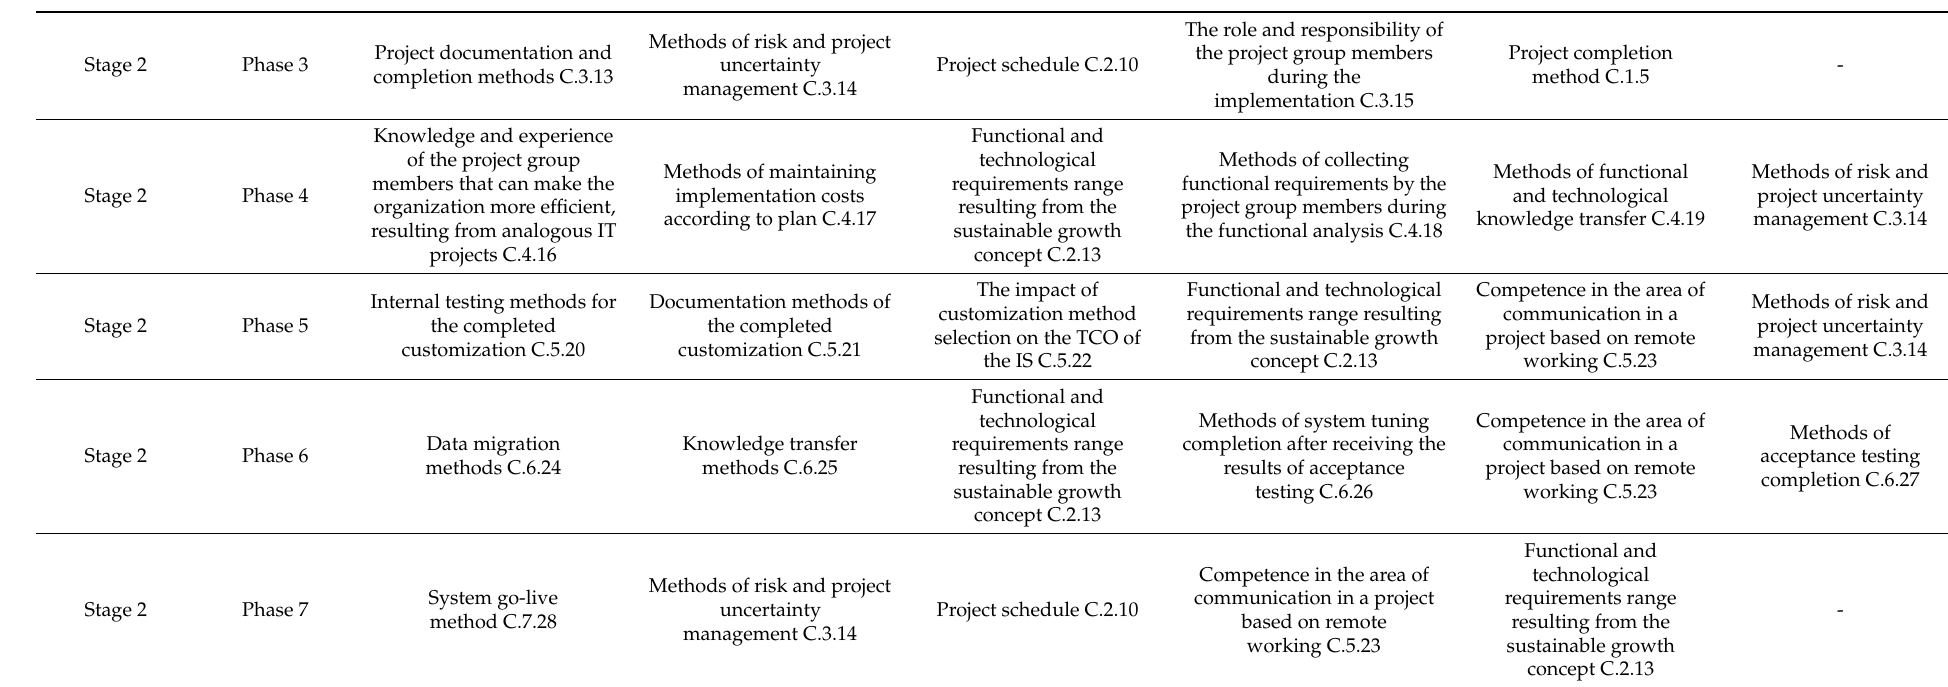
Table 4. The structure of information components on the client’s side during Stage 2 of the IT implementation projects. Source: Own